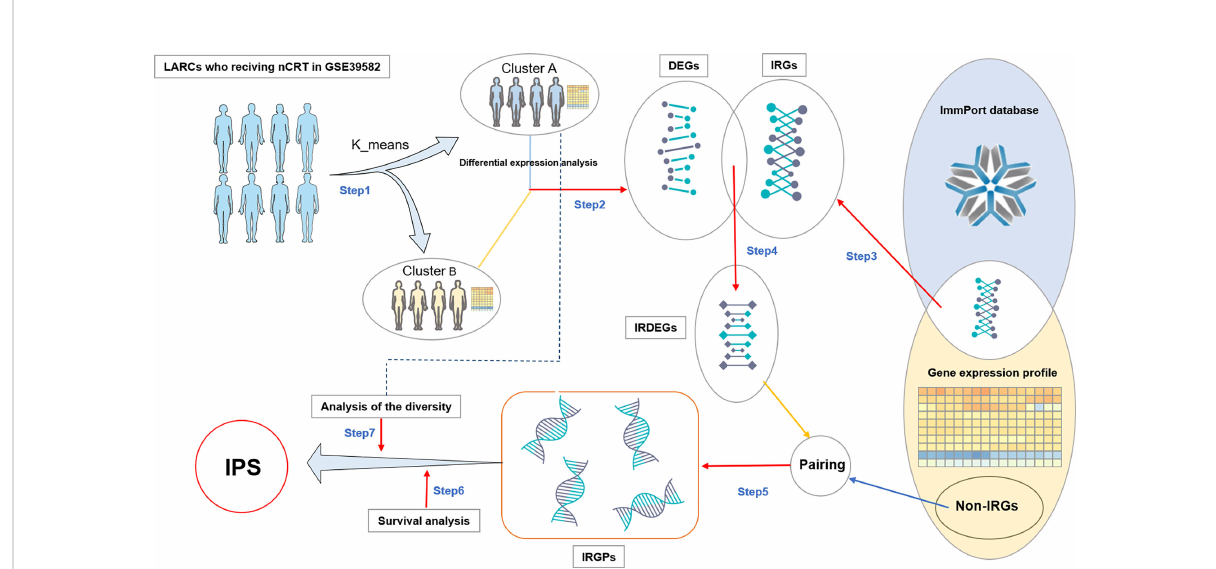
FIGURE 1 Flowchart of IPS discovery process. DEGs: differentially expressed genes. IRGs: Immune-related genes. IRDEGs: Immune-related differentially expressed genes. Non-IRGs, Non-immune-related genes; IRGPs, Immune-related gene pairs; IRGPS, Immune-related gene pair Signature.